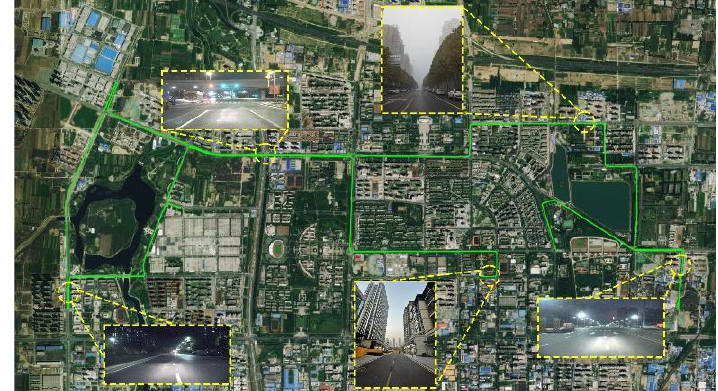
Figure 4. The trajectory of the experiment.